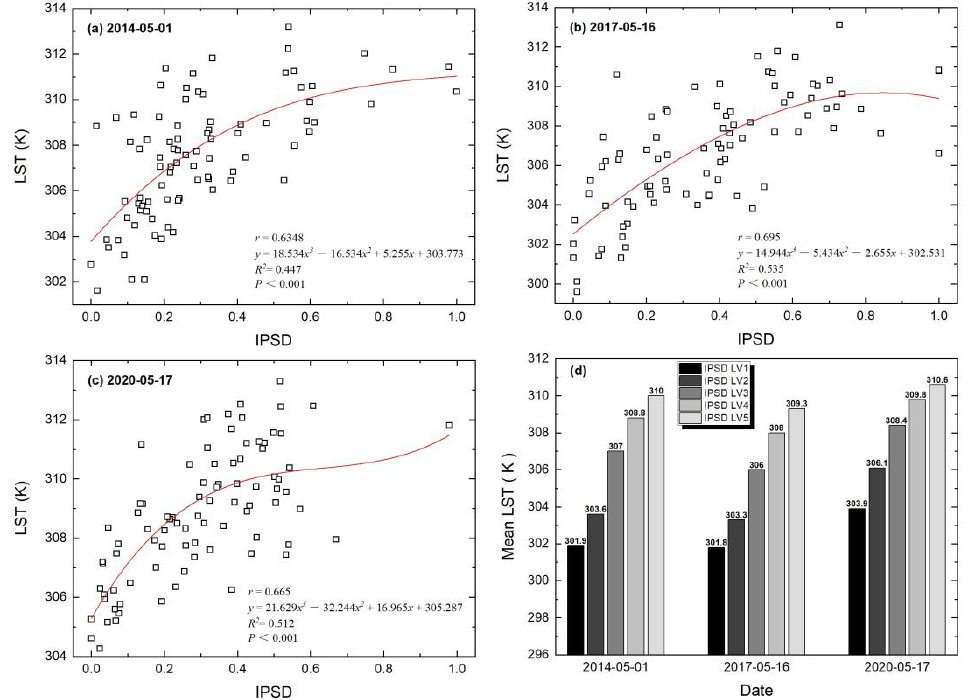
Figure 6. The inversed component fraction validation using a GF-1 image (taking the inversed vegetation and IPS fractions of 17 May 2020 as an example).